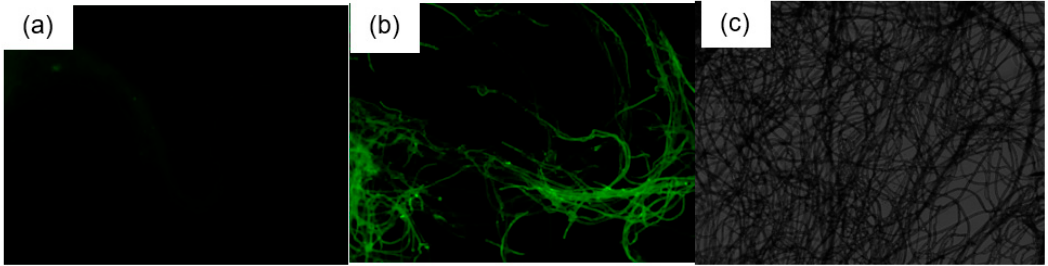
Figure 2. Visualization of FITC-tagged enzyme using fluorescence microscope: ( a ) PSNF fluorescence background, ( b ) FITC-PSNF- β -Gal with fluorescence excitation ( c ) negative control PSNF- β -gal without fluorescence